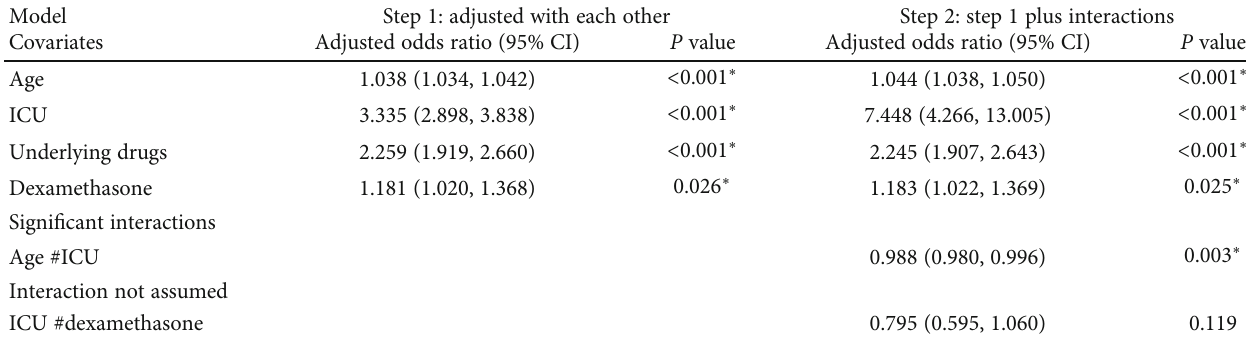
Table 5: Logistic regression model for association of dexamethasone with death and the signi fi cant interactions.